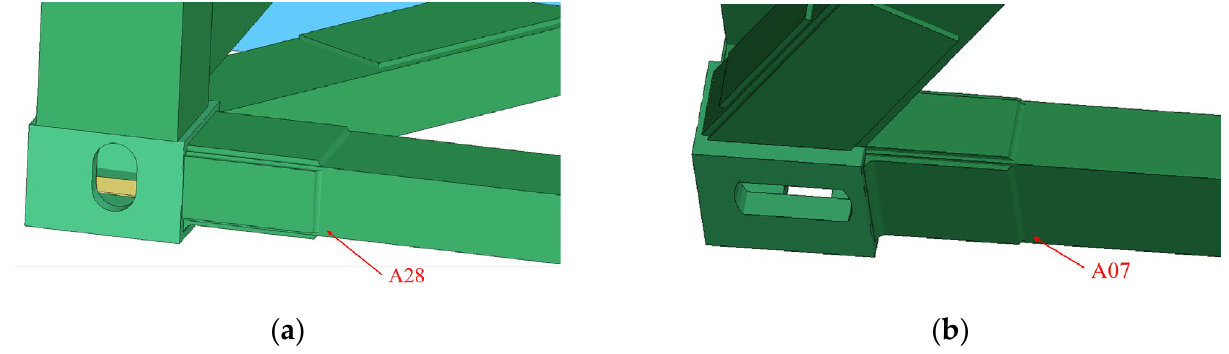
Figure 11. Location of A28 and A07 in the finite element model: ( a ) A28; ( b ) A07.